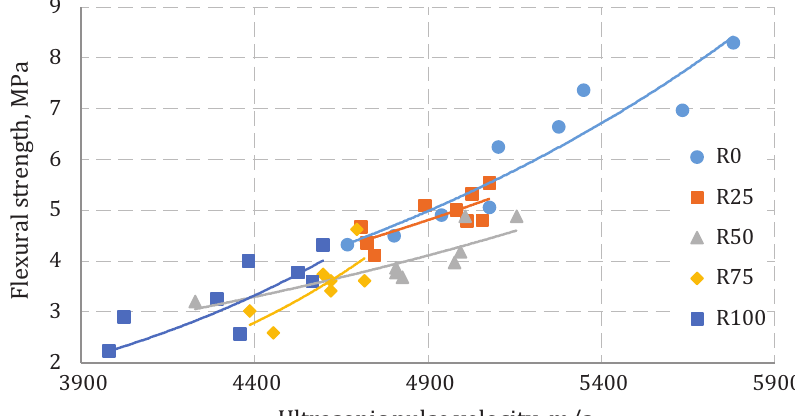
Figure 13. Flexural strength-UPV curves